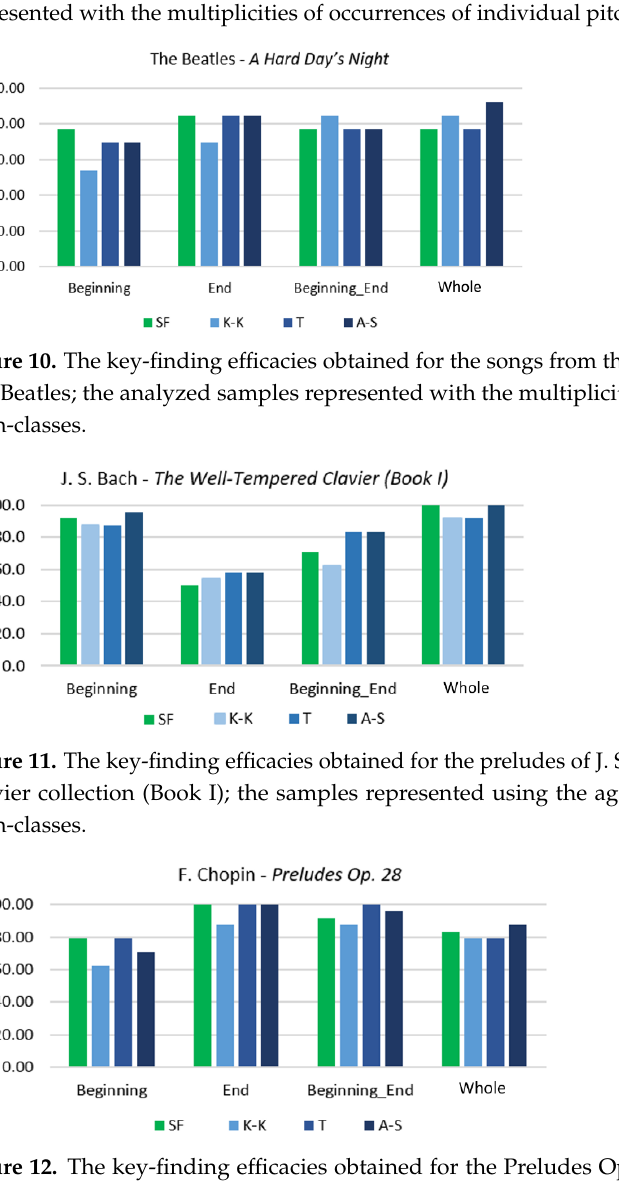
Figure 13. The key- finding efficacies obtained for the songs from the album A Hard Day’s Night by The Beatles; the samples represented with the aggregate durations of individual pitch-classes. One of the purposes of the experiments we conducted was to find out whether it is worth analyzing the entire piece of music in order to determine its key, or if it is enough to analyze much shorter fragments. In general, determining the key based on the entire piece should provide better results, however, the analysis of the entire piece may not al- ways be desired or possible. We decided to compare the different key detection ap- proaches in terms of various sample selection options (Beginning, End, Beginning_End, Whole), regardless of the type of the sample’s pitch -class representation. The outcome of this comparison is shown in Figure 14, which indicates that the most accurate way of de- termining the key was achieved when the analysis was performed on the whole piece. The exception to this was the approach using Temperley key-profiles, in which case the best results were observed for the analysis of the concatenation of fragments located at the beginning and the end of a given composition. There are scenarios when one may wish to evaluate the key in a real-time manner. In such cases, it is important to have an effective way of determining the key based on the shortest possible fragment of music. Figure 14 clearly shows that the key detection ap- proach based on the signature of fifths gave the best results when the analysis was per- formed on the initial fragments of music. In order to confirm the high efficacy of the method utilizing the signature of fifths while dealing with short fragments of music, ad- ditional experiments were performed.